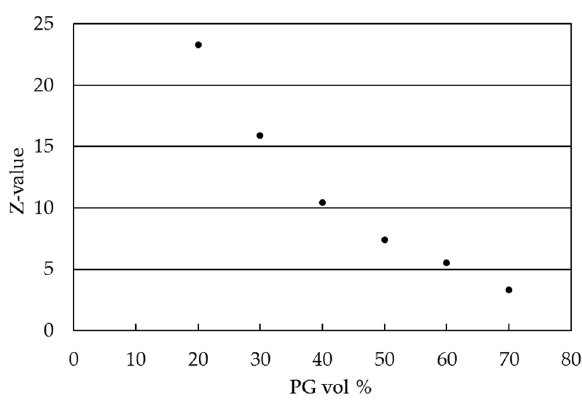
Figure 1. Ink formulation guidance: calculated Z-values of inks with 20–70 vol % of PG.